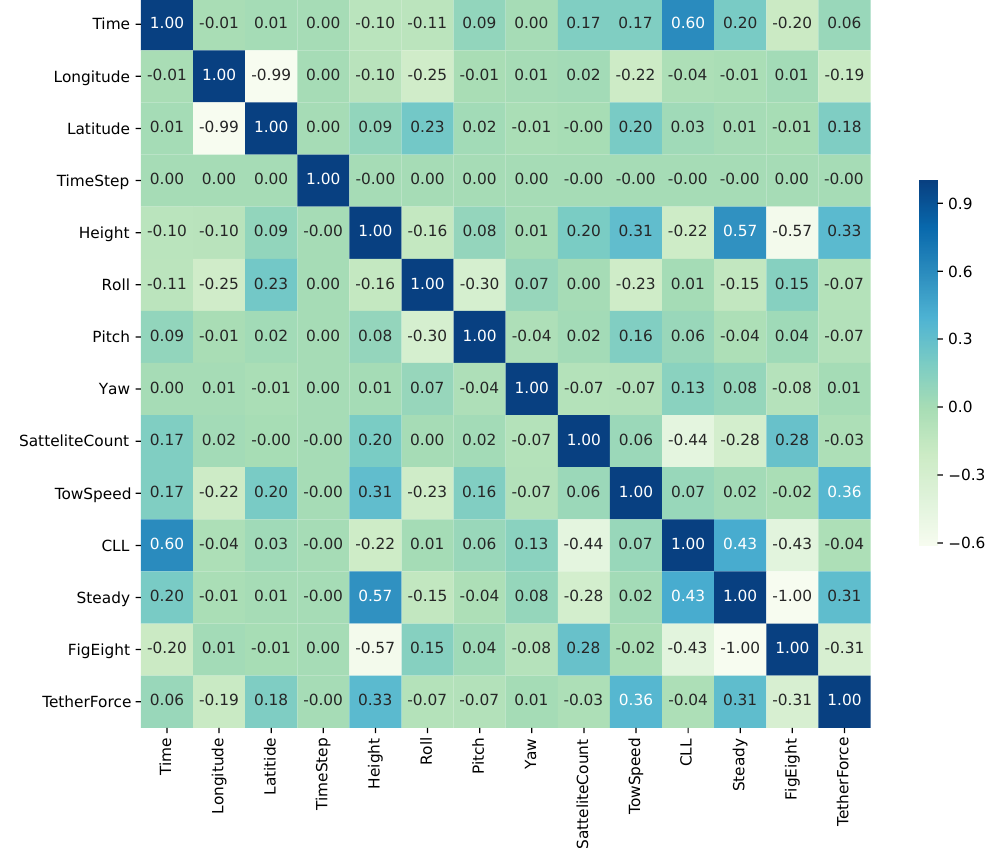
Figure 18. Pearson correlation coefficient for tow